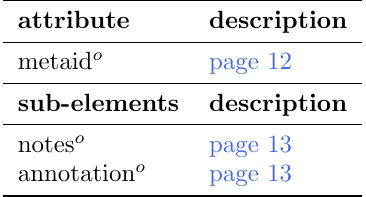
Table 2.1: Attributes and nested el- ements for SEDBase. o denotes op- tional elements and